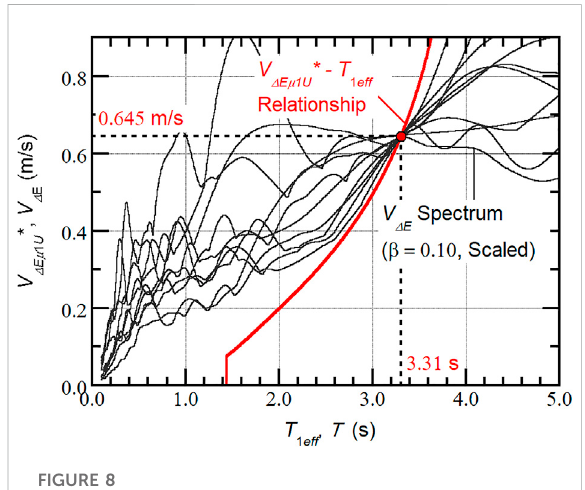
FIGURE 8 Maximum momentary input energy spectra of the scaled ground motion